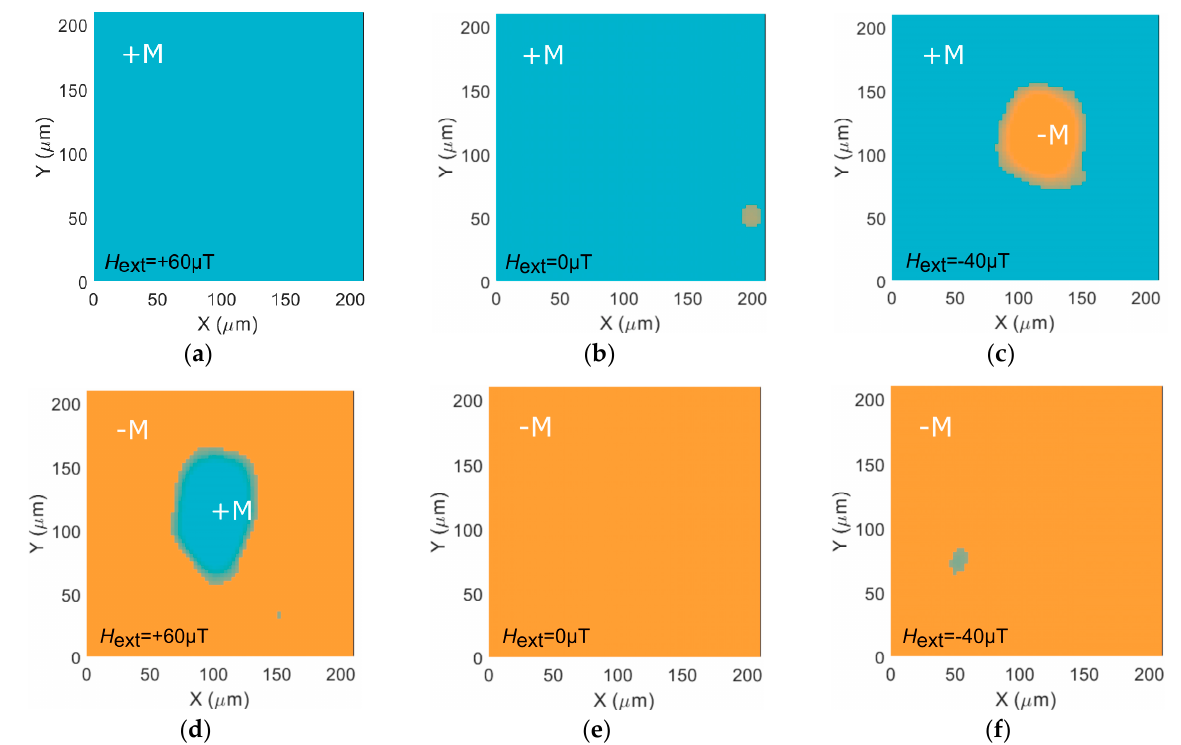
Figure 4. Optical switching of the GdFeCo film under the application of an external magnetic field in the direction of the Earth’s magnetic field and along the easy axis of magnetic anisotropy ( α = 0 ◦ ). Images of the GdFeCo magnetization state after the femtosecond pulse action with ( a – c ) + M and ( d – f ) – M initial magnetization under the application of the resulting magnetic field ( a , d ) H ext = + 60 µ T, ( b , e ) H ext = 0 µ T, ( c , f ) H ext = − 40 µ